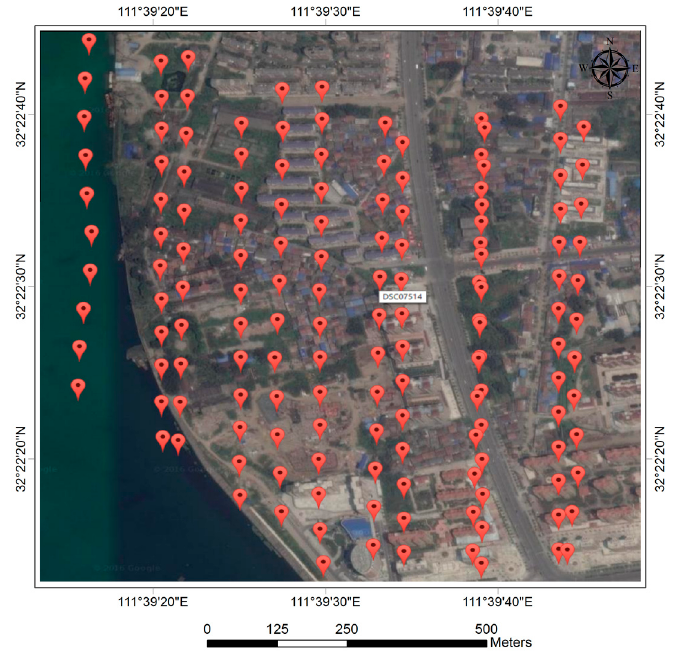
Figure 1. GPS coordinates of images overlay. The red labels are GPS coordinates of each image.